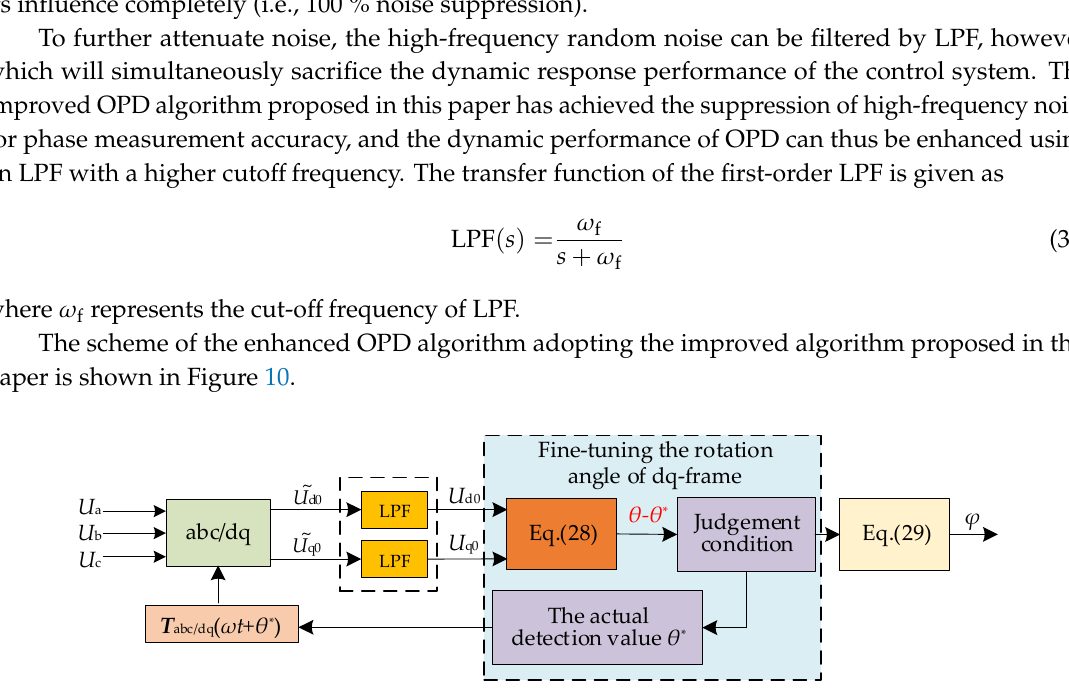
Figure 10. Scheme of the enhanced OPD by fine-tuning the rotation angle of the dq frame.